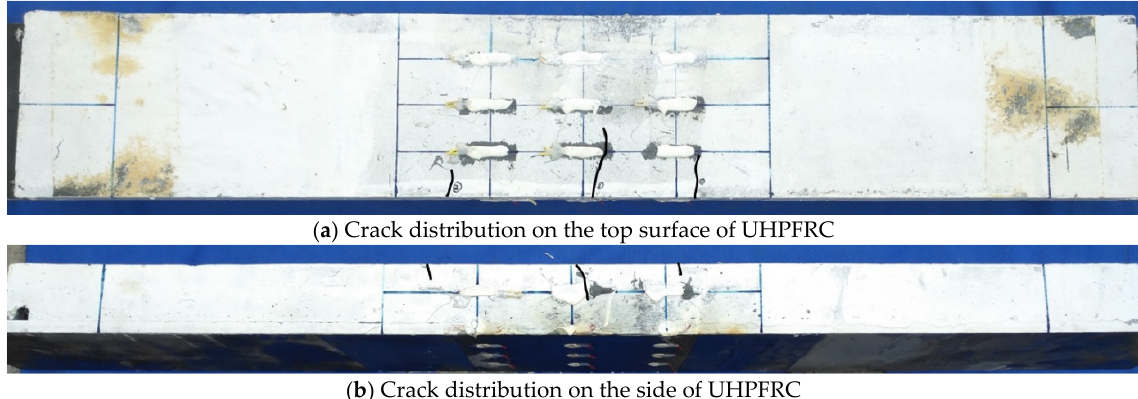
Figure 21. Crack distribution of